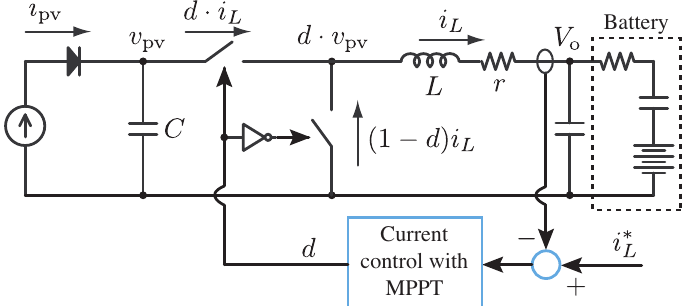
Figure 2. Large-signal averaged circuit of a PV step-down converter with active rectification.